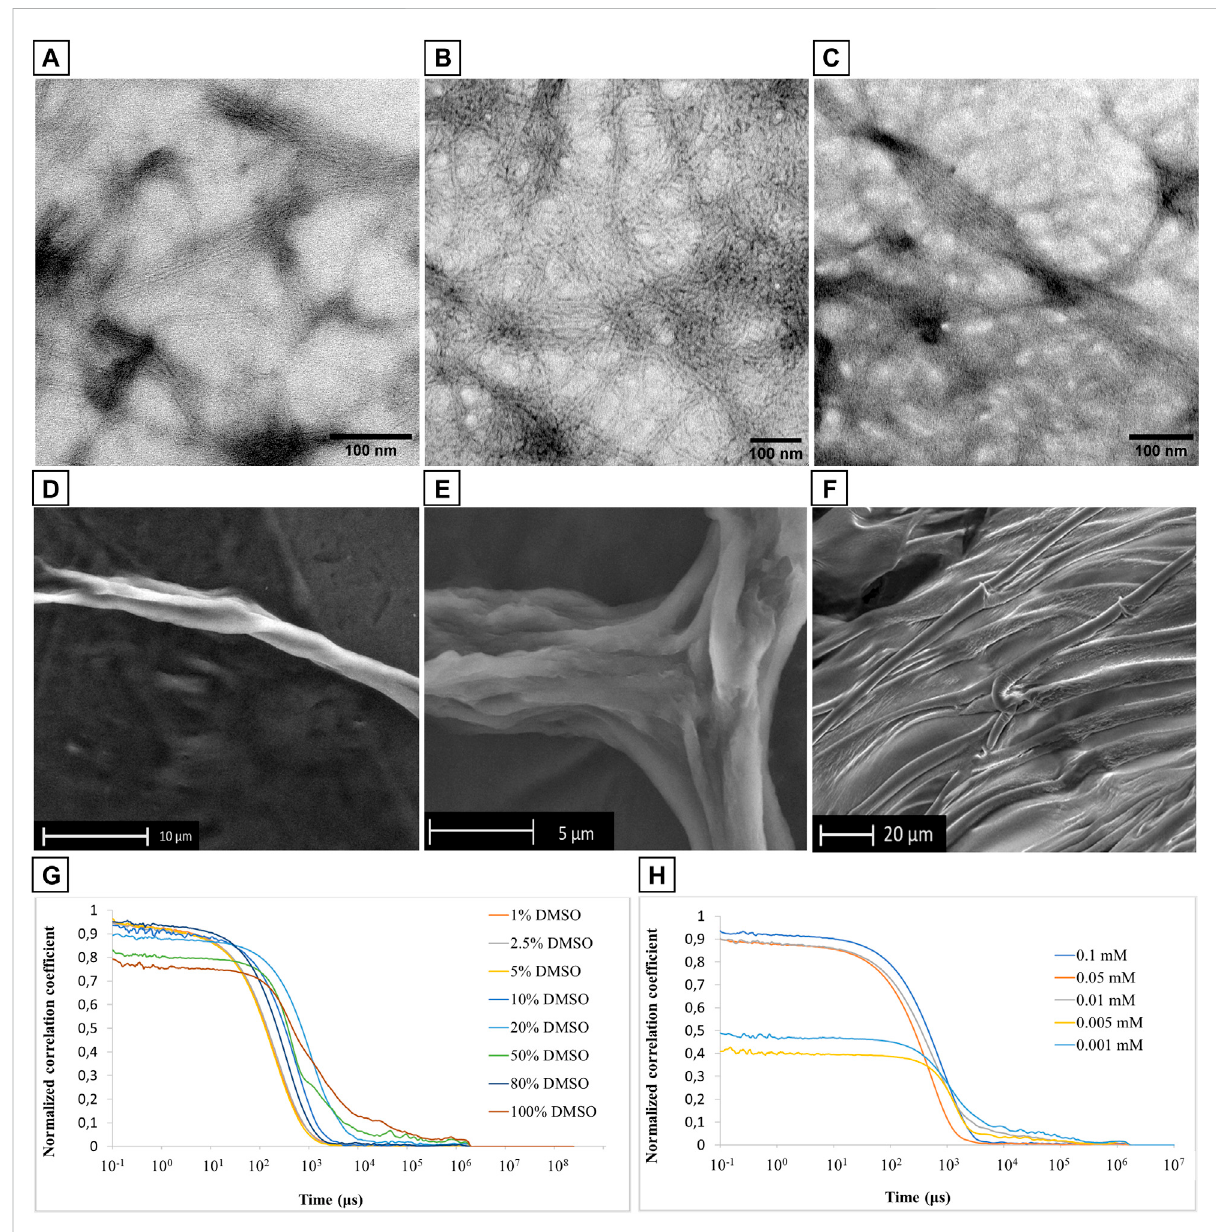
FIGURE 4 (A – C) : TEM micrographs of fi lamentous assembly of PMP-2 from 0.1 mM solution at pH 7.6 (A) , and pH 4 (B,C) . (D – F) : SEM images of PMP-2 from0.5 mMsolutionatmeasuredpH=7.6. (G,H) :DLSmeasurementsofPMP-2: (G) NormalizedautocorrelationfunctionsatdifferentDMSO/water mixture, and (H) normalized autocorrelation functions at different concentration (H)